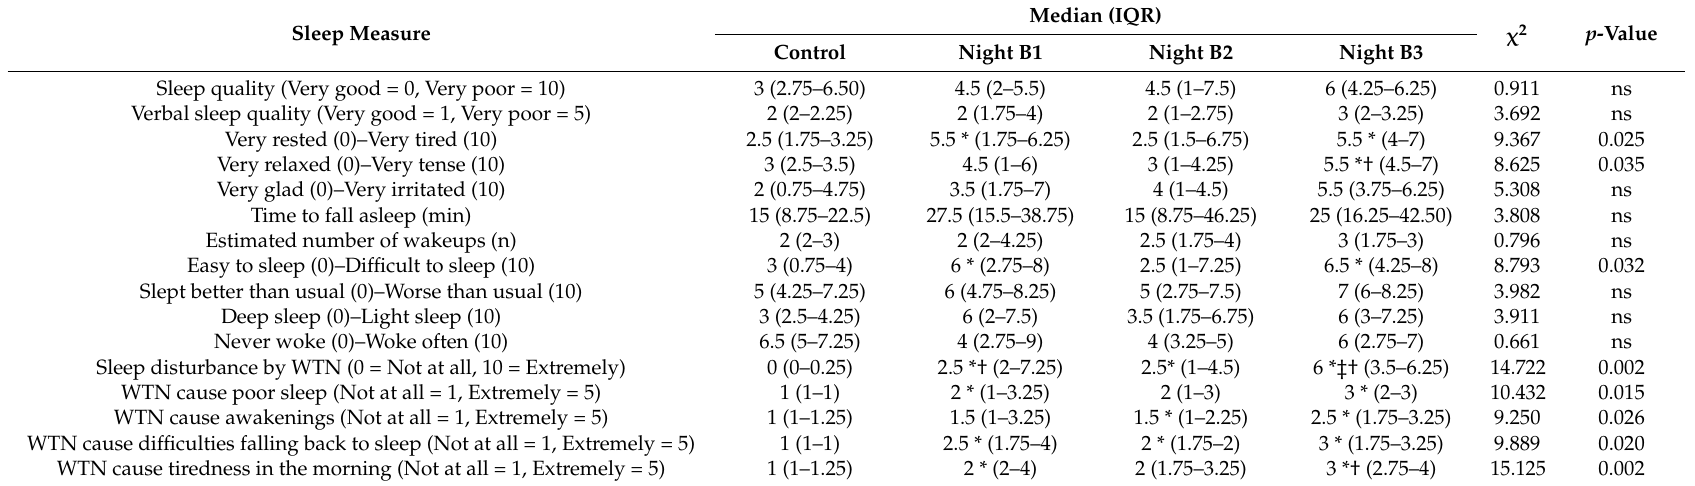
Table 7. Self-reported sleep variables in Study